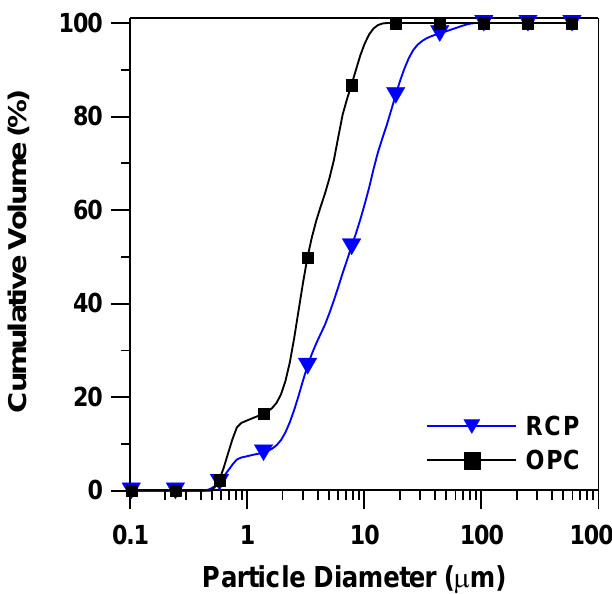
Figure 4. Particle size distribution of RCP and OPC powders.